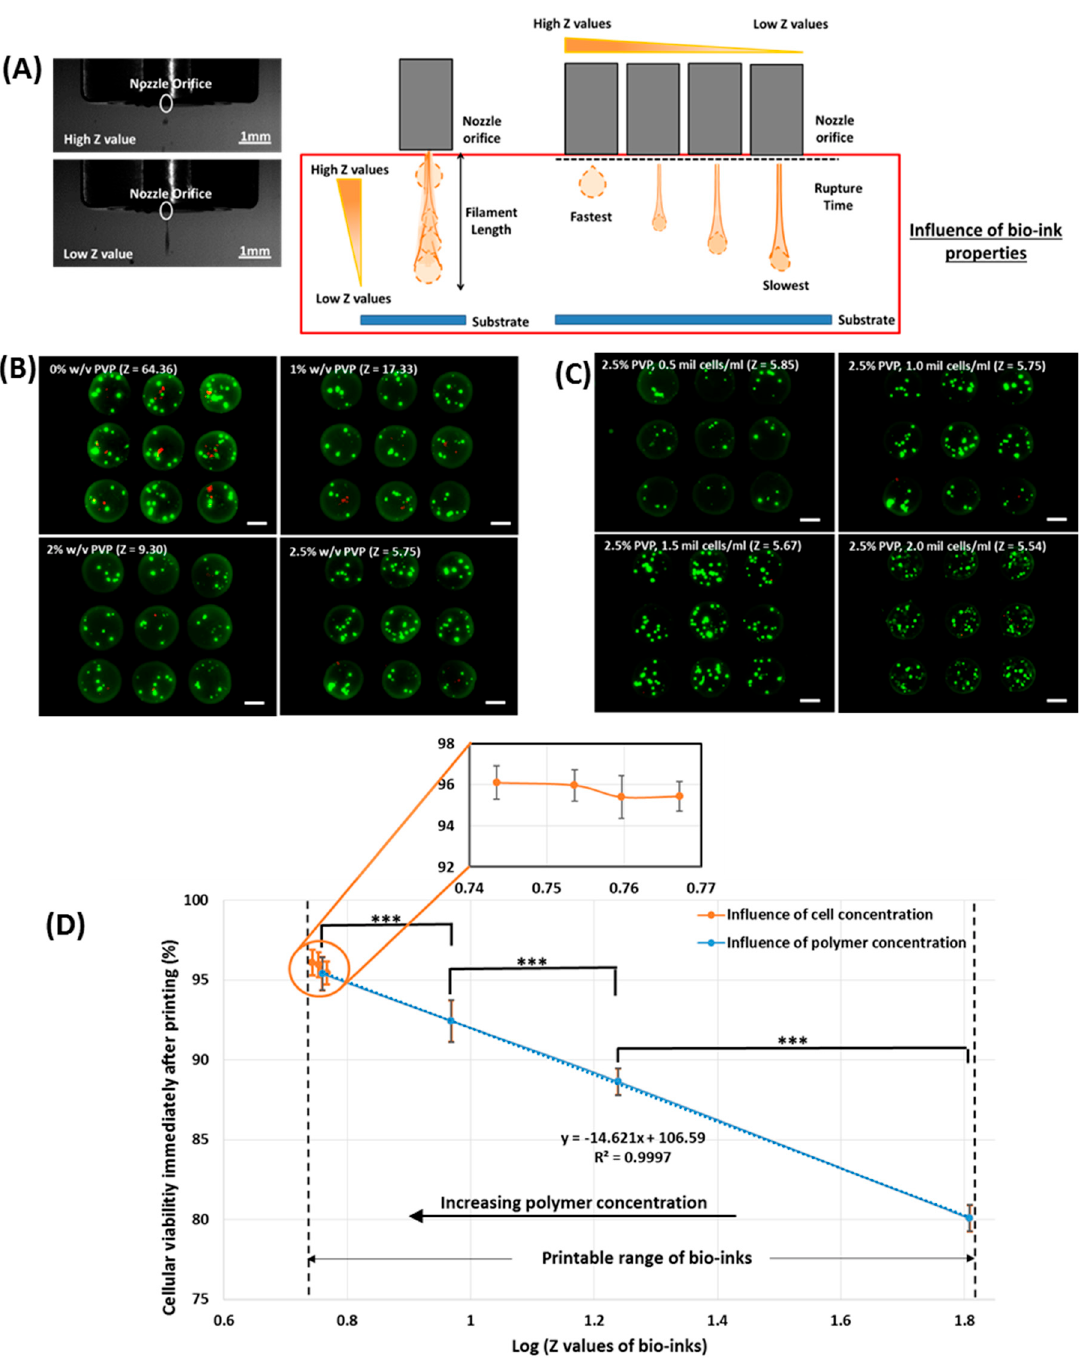
Figure 1. ( A ) ( Left ) Representative images of droplet generation at both low and high Z values ( Right ) Schematic drawing of the printing process; ( B ) Influence of polymer concentration (0%–2.5% w/v, constant cell concentration of 1 mil cells/mL) on Z values and corresponding viability; ( C ) Influence of cell concentration (0.5–2 mil cells/mL, constant polymer concentration of 2.5% w/v) on Z values and corresponding viability (scale bar: 200 µ m); ( D ) Short-term viability of printed cell droplets ( n = 135) immediately after printing (mean ± SD). Significance levels are as follows: p < 0.005 (***), p < 0.05 (*).